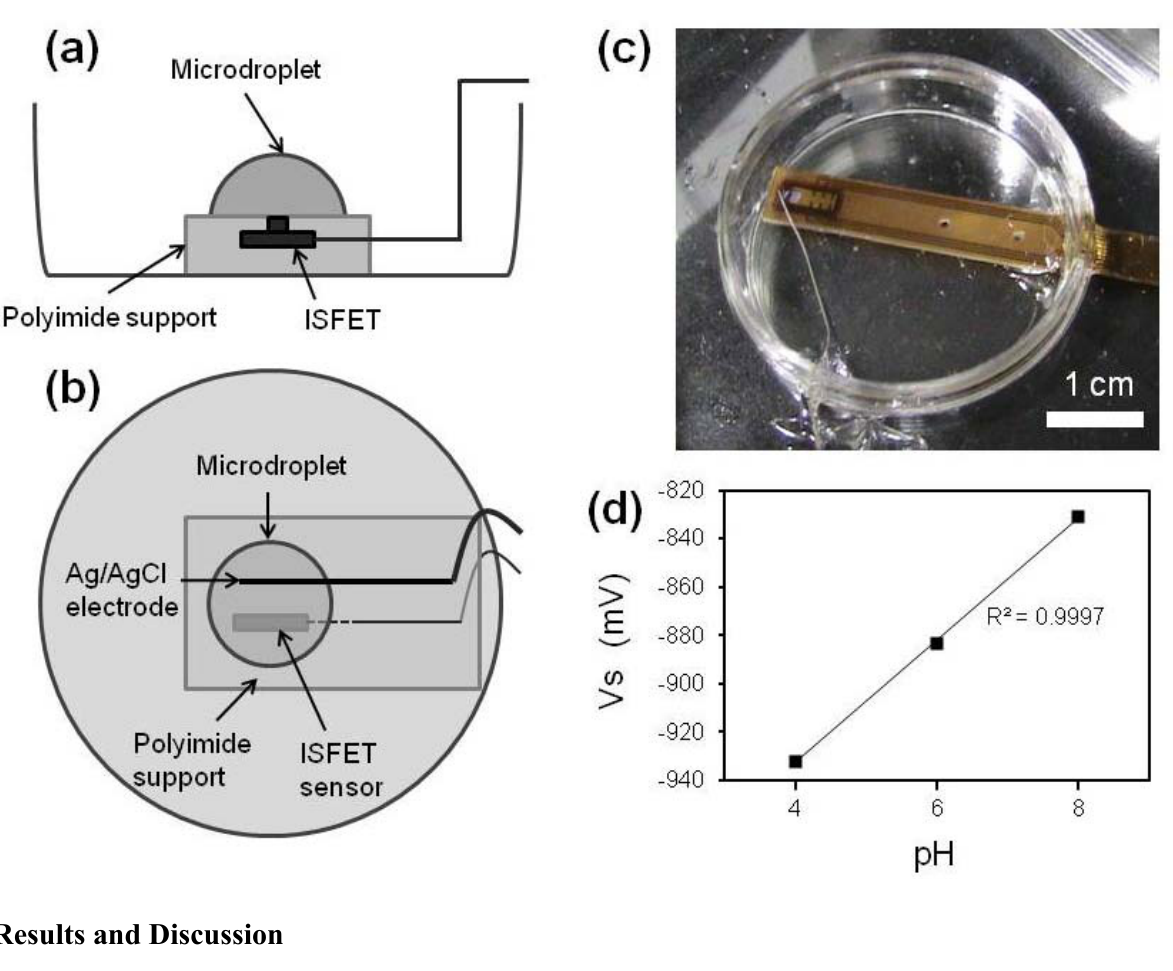
Figure 2. Detection device of the ISFET measurement system. ( a ) Side and ( b ) Top view of schematic presentation. ( c ) Photograph of the measurement system. ( d ) Linear relationship between pH and gate-source voltage (V ) of optimized buffers at pH 4, 6, and s